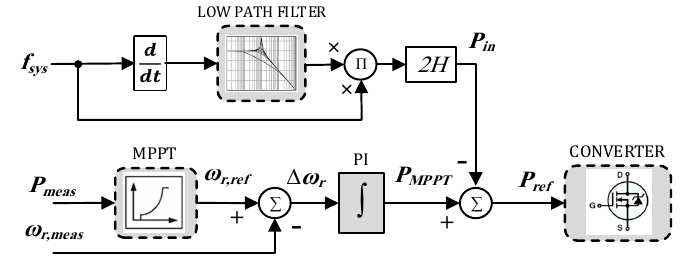
Figure 5. Releasing hidden inertia controller.